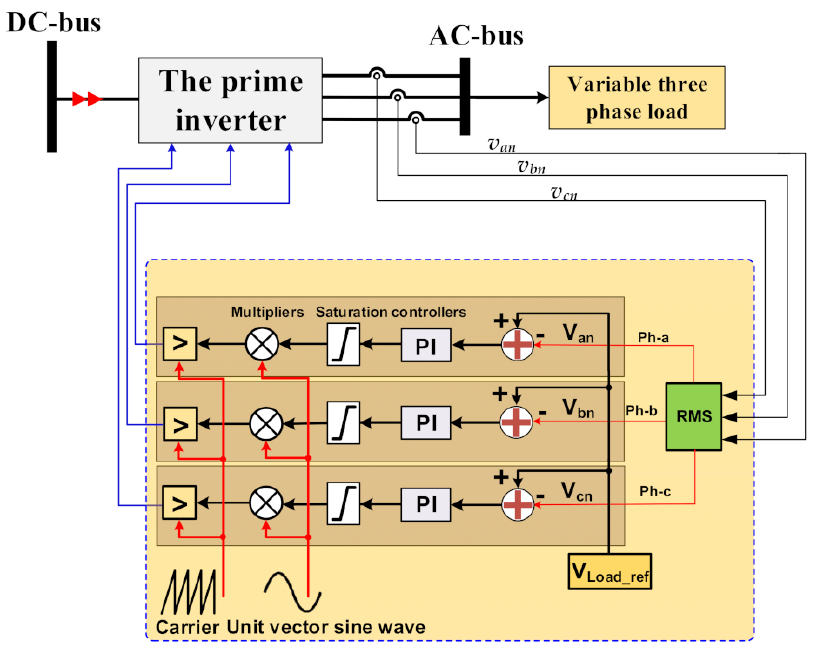
Figure 8. The prime inverter control